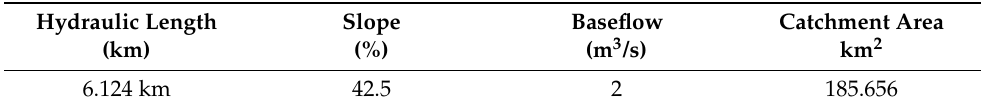
Table 3. Values of parameters used to calibrate the model.